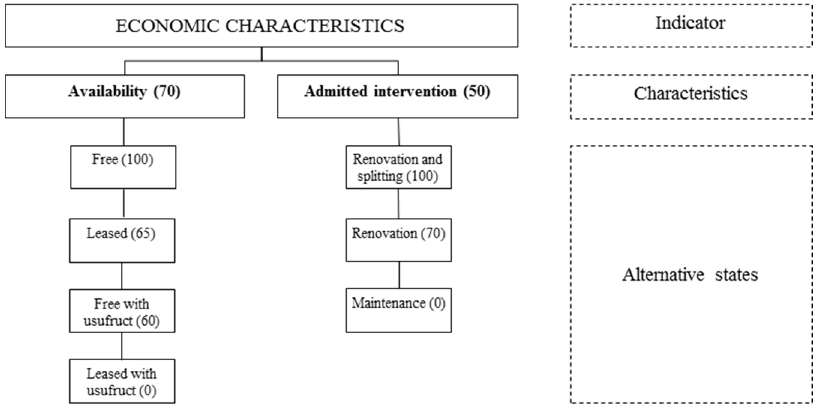
Figure 6. The structure of the “economic” indicator ( c e ).